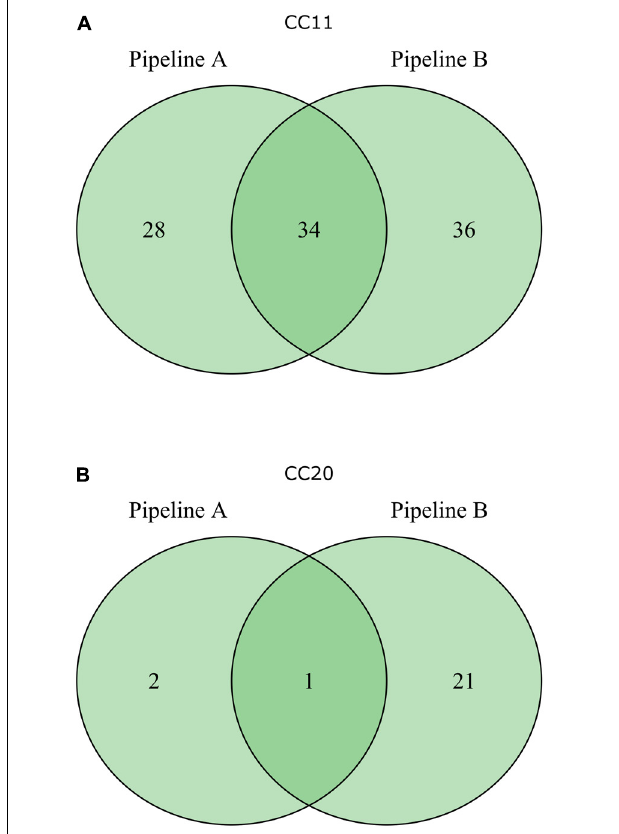
FIGURE 4 | Venn diagrams depicting the results of CC11 (A) and CC20 (B) marker prediction by pipeline A and pipeline B based on an identical set of 63 E. coli genome